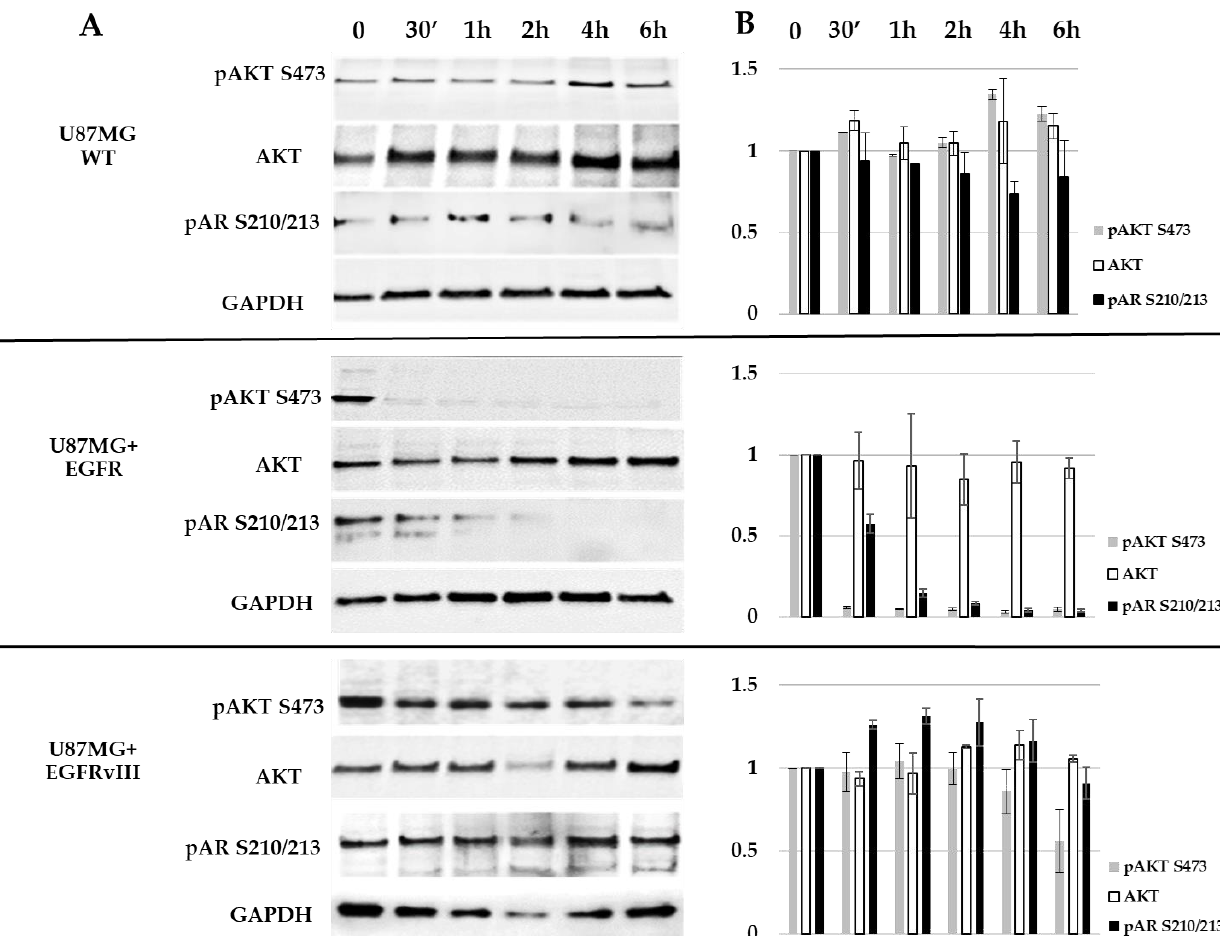
Figure 5. Western blot analysis of AR S210/213 and AKT S473 in U87MG subclones. ( A ) Cells were treated for 30 min (30′) to 6 h with 5 μM afatinib and analyzed with Western blotting using antibodies against AKT, pAKT (S473), and pAR (S210/213). The anti-GAPDH housekeeping protein was used as a loading control. ( B ) Protein fold change (Y-axis) of each sample compared to treatment at time zero was calculated according to band densitometry analysis with ImageJ software, following normalization to GAPDH .